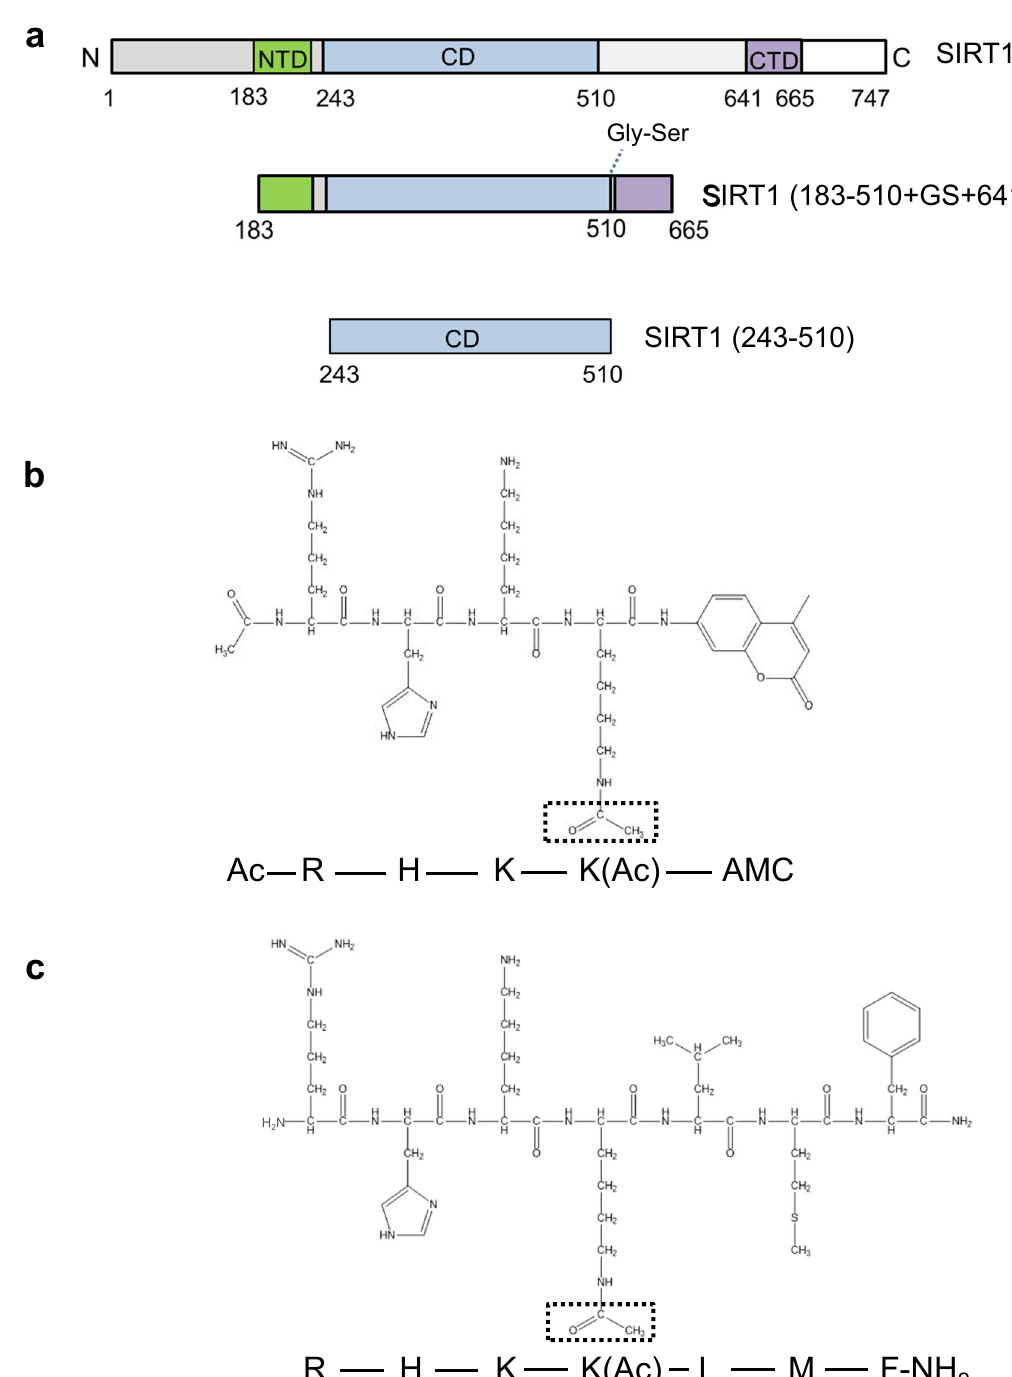
Fig. 1 SIRT1 fragments and p53-derived peptides used in this study. a A schematic diagram showing functional domains in full-length SIRT1 (top) and two truncation variants (SIRT1 183 – 510 + GS + 641 – 665 and SIRT1 243 – 510) used for ITC. b The fl uorogenic peptide substrate used in the Fluor de Lys SIRT1 fl uorimetric assay. c The native p53-derived peptide used for